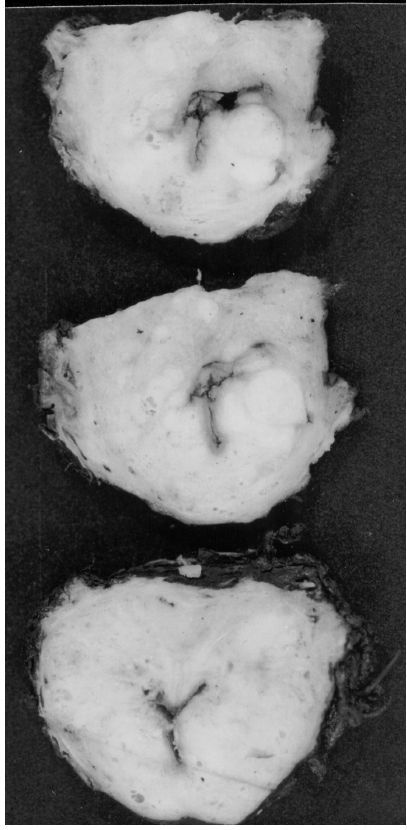
Figure 1 – The previously fixed surgical specimen was weighed, measured, and the entire surface inked. The bladder neck and apical margins were amputated. From each cone-shaped amputated margin, 8 fragments were processed through perpendicular sections relative to the margins. The rest of the prostate was serially cut in transverse sections at 3 to 5 mm intervals, as shown.